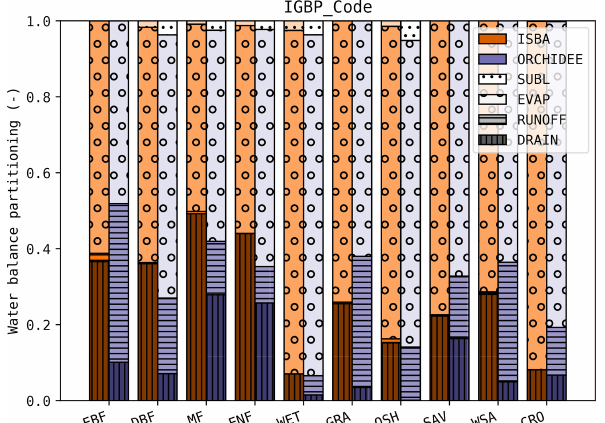
Figure 8. Average water balance partitioning (deep drainage, runoff, evapotranspiration and sublimation) per PFT class in ISBA and ORCHIDEE.